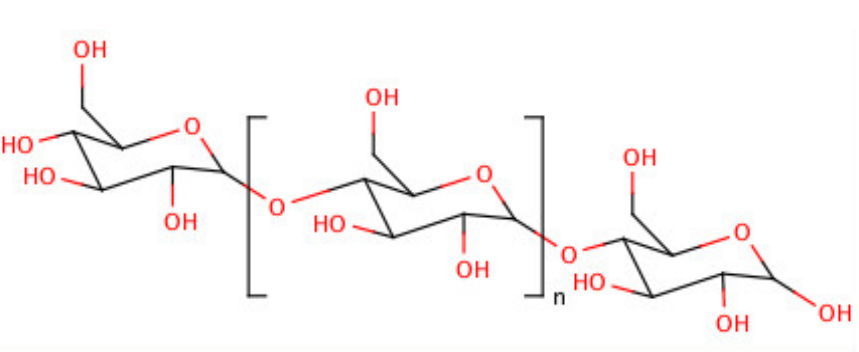
Figure 4. The structure of